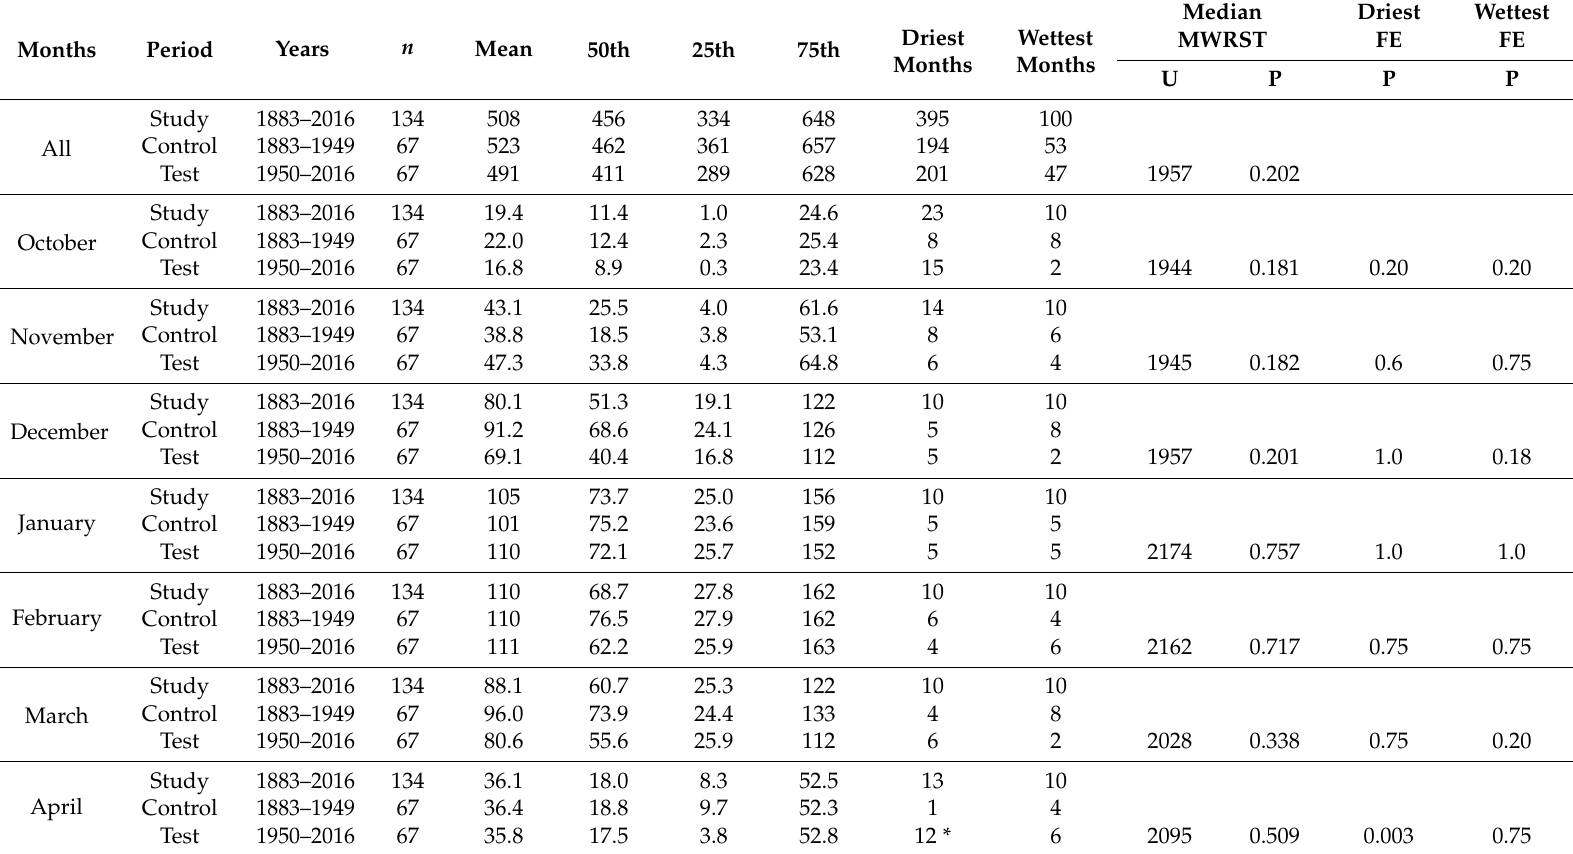
Table 4. Rainfall in Pasadena between 1883 and 2016 compared by the Mann-Whitney Rank Sum Test and Fisher Exact Test.All Results are in millimeters of rain or Number of